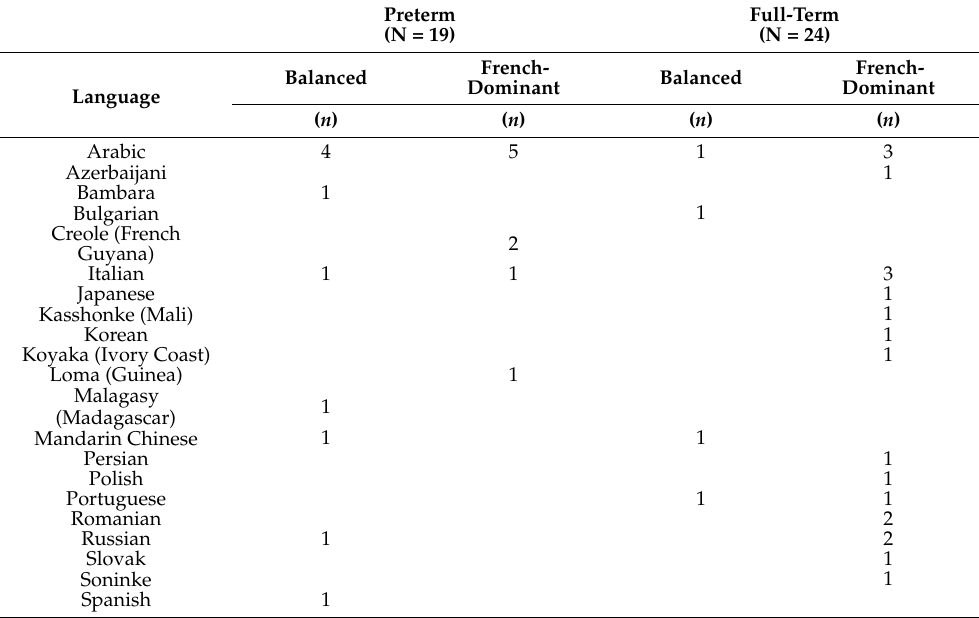
Table 2. Language background of preterm and full-term